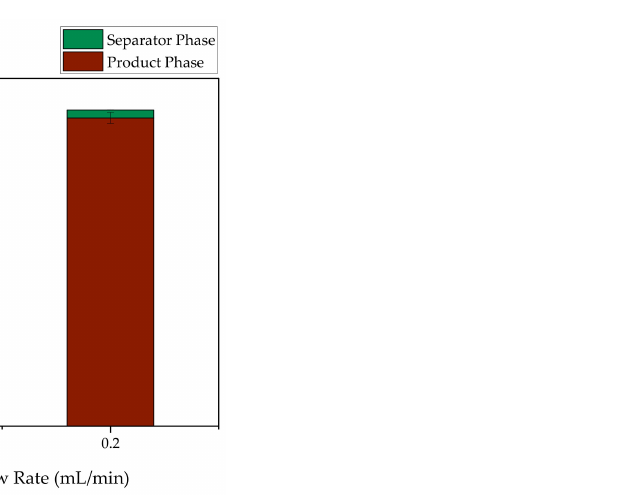
Figure 13. Product phase composition in percent for a volume flow of 0.2 mL/min as well as a volume flow of 1